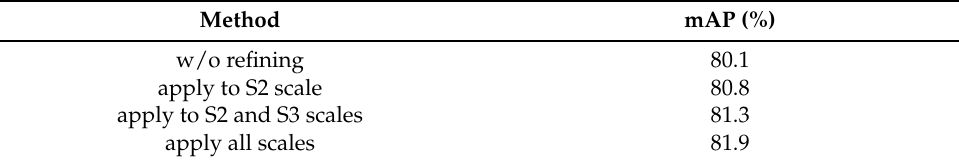
Table 9. Comparison of the compressed